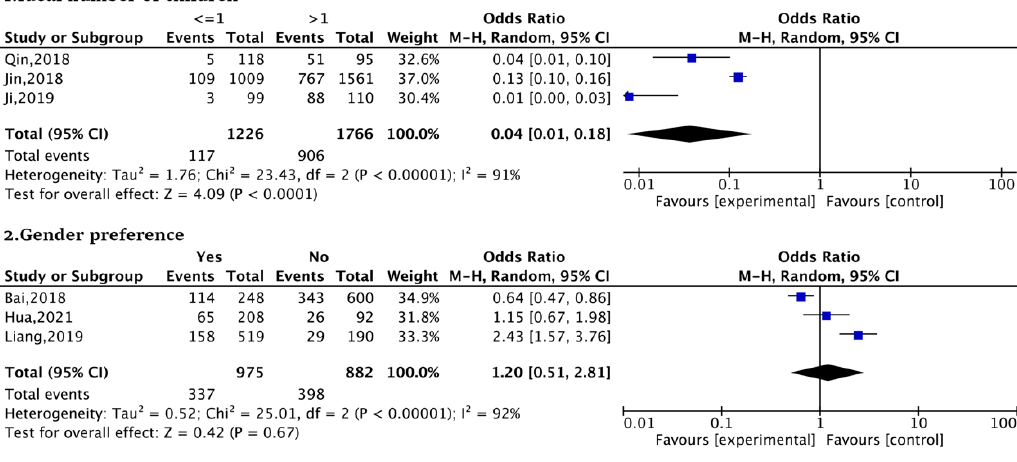
Figure 3. Forest plots of fertility